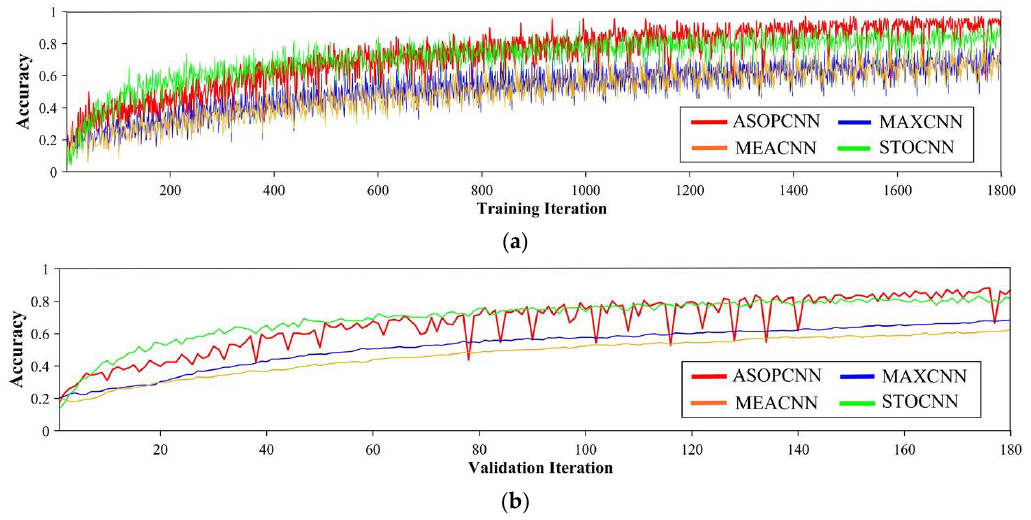
Figure 12. ( a ) The changing process of model accuracy on the training set; ( b ) the changing process of model accuracy on the verification set. Table 3. The final accuracy on training and verification